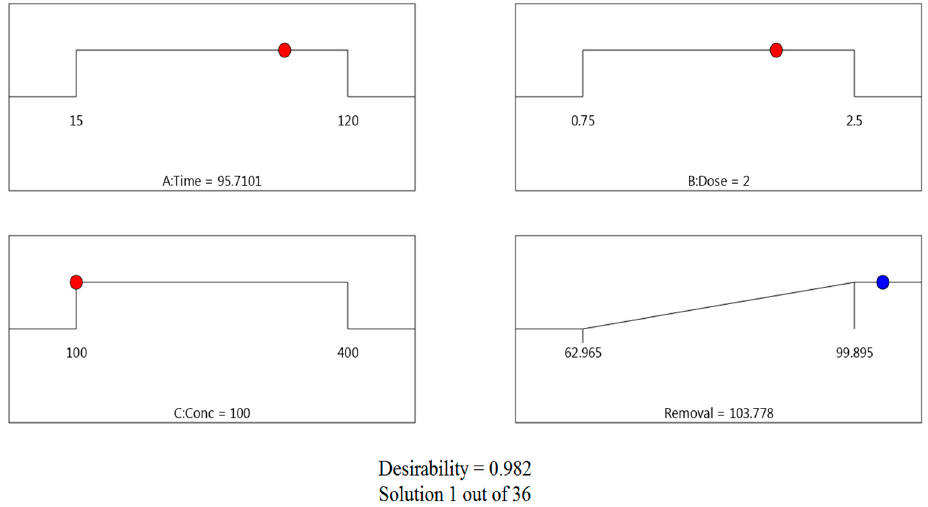
Figure 16. Optimum conditions predicted by RSM method.